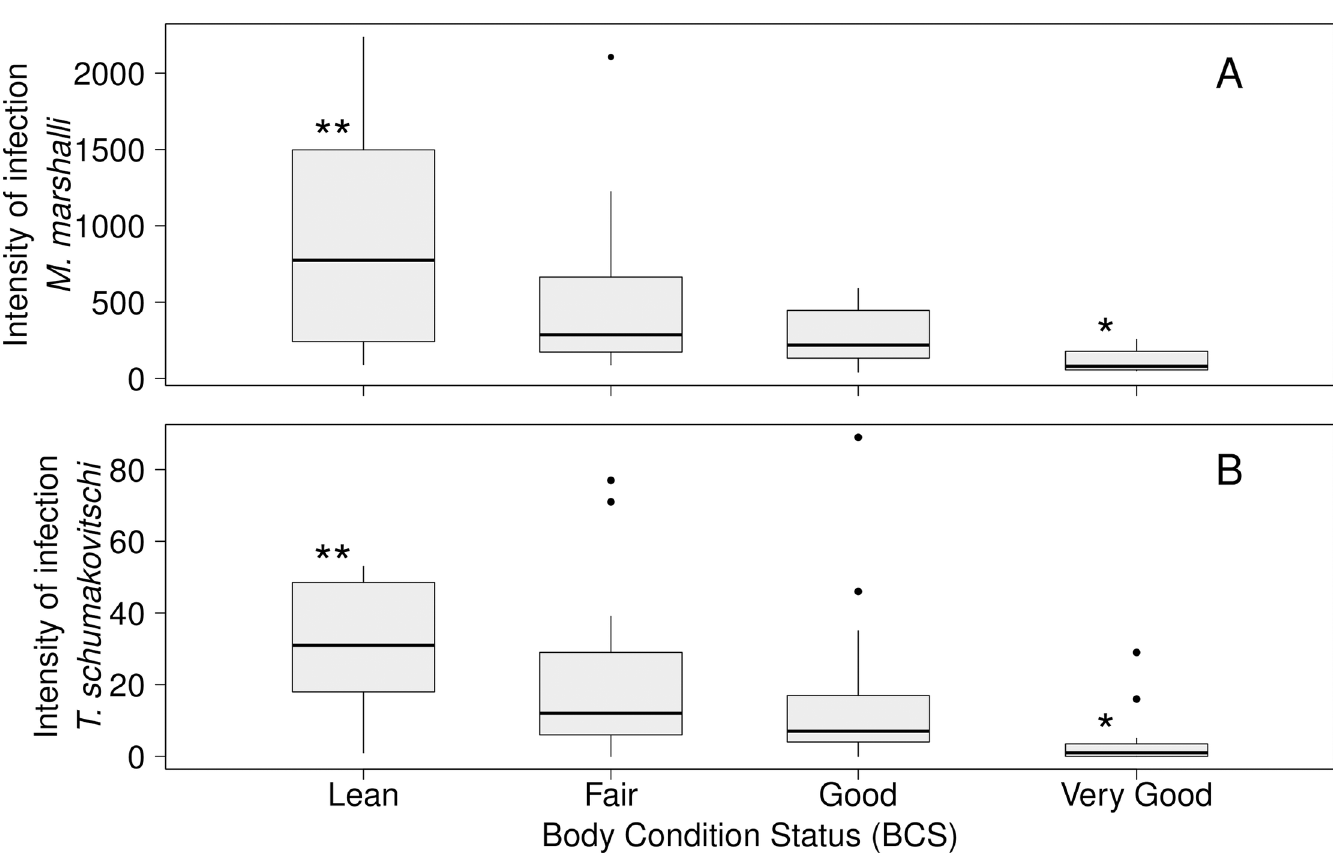
Fig 3. Infection intensity of gastrointestinal helminths in adult Dall’s sheep categorized by body condition (BCS). A) Total infection intensity of M . marshalli (Pairwise comparisons, n = 42, Lean-Very Good, W = -2.674, p = 0.0249). B) Infection intensity of T . schumakovitschi (Pairwise comparisons, n = 61, Lean-Very Good, W = -2.816, p = 0.0291). Significant differences among categories (p < 0.05) are represented with “ (cid:3) ”.